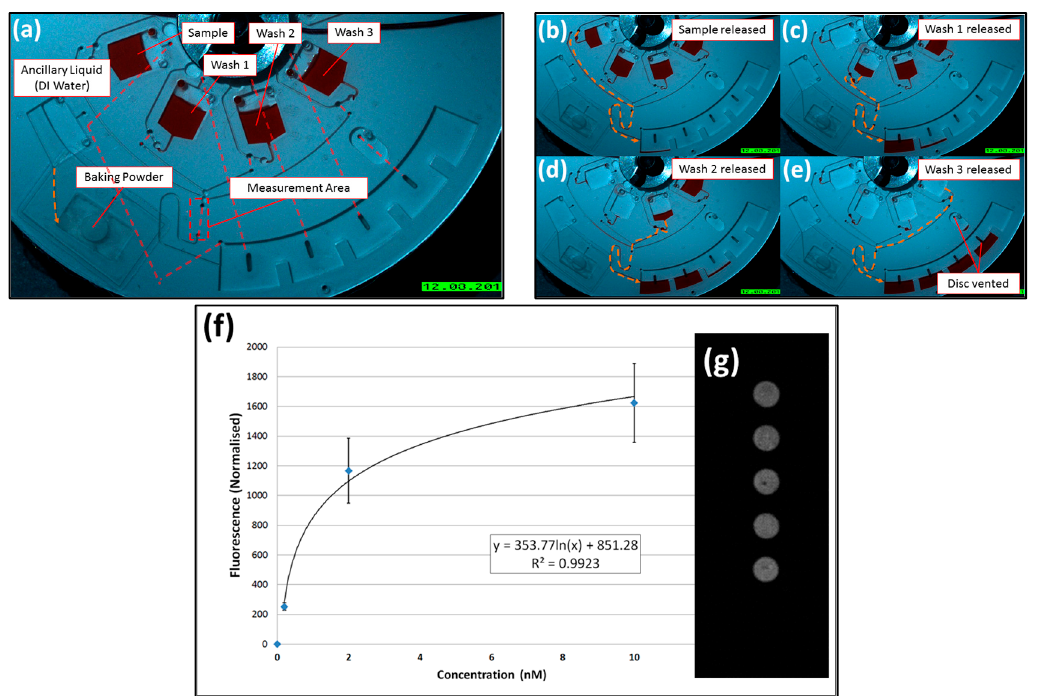
Figure 4. A direct DNA hybridization assay. ( a – e ) Visualization of the chip, using food dyes, of the sequential release of sample and washes. Note that the last DF vents the disc to atmosphere. The red dashed lines in ( a ) show lower level connecting channels; ( f ) fluorescence versus loaded sample concentration ( n = 3 discs); and ( g ) is a representative image showing fluorescent DNA hybridization on the slide. Note the disc was initially designed so that, before the liquid-induced release of CO 2 , the all DF burst valves will not trigger at or below 30 Hz spin rate (see Supplementary Material Video S1)